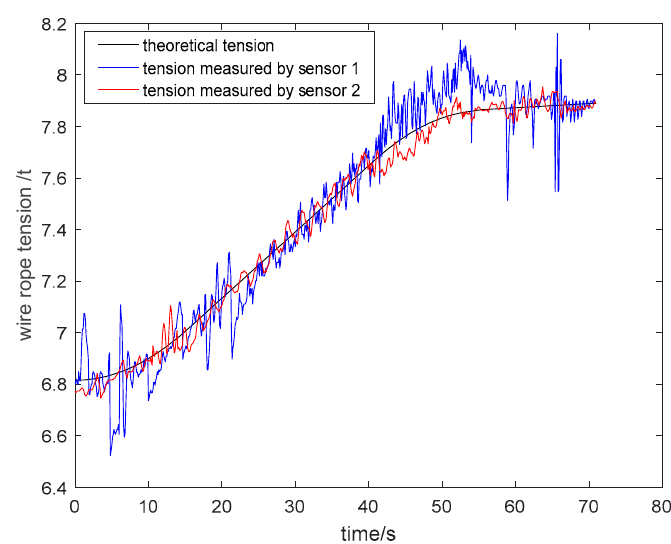
Figure 28. Tension curves during lifting process of cage with load.